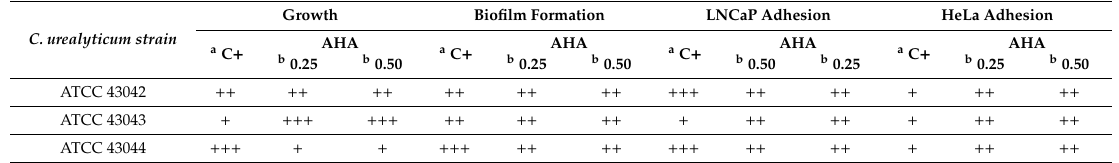
Table 2. Results of the e ff ect of AHA on in vitro tests for C. urealyticum strains